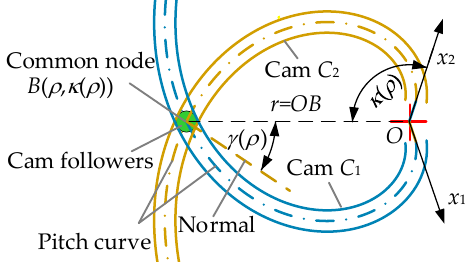
Figure 2. Cam curve described in the polar coordinate system.